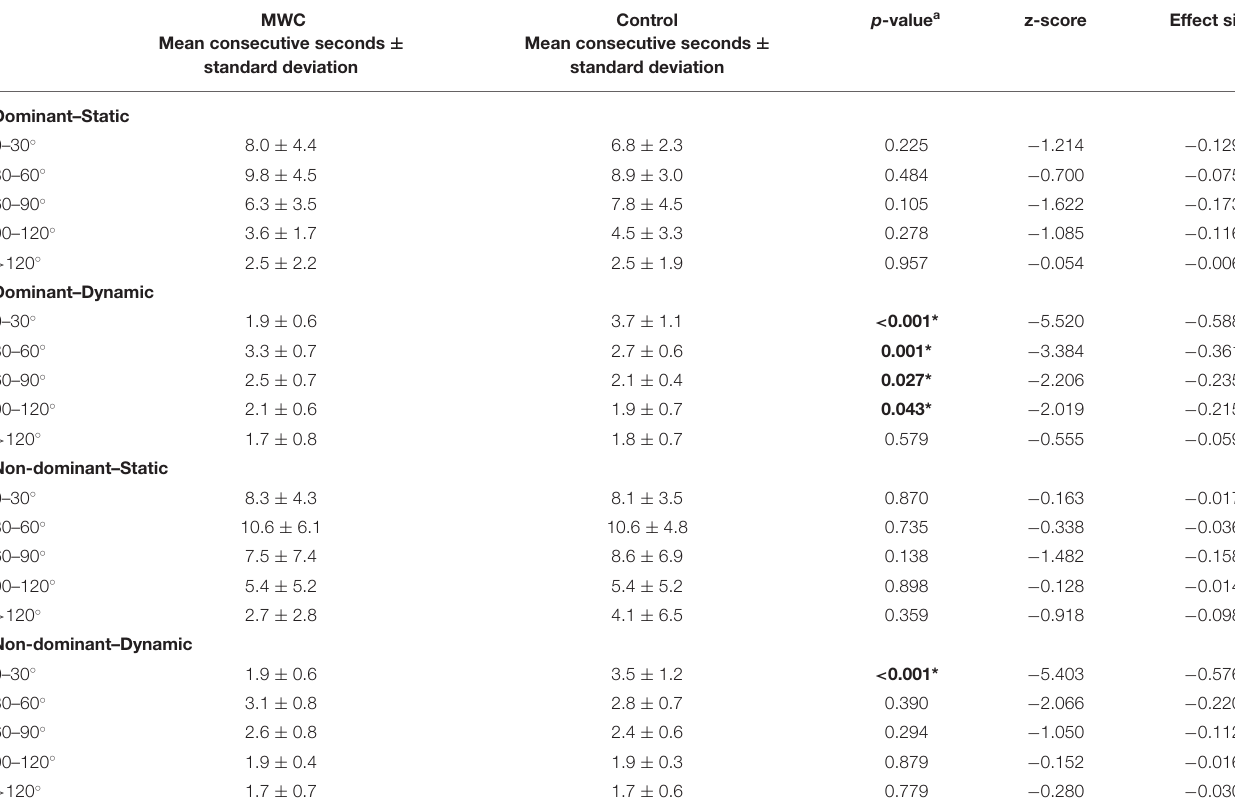
TABLE 4 | The average consecutive duration of static and dynamic periods in each humeral elevation